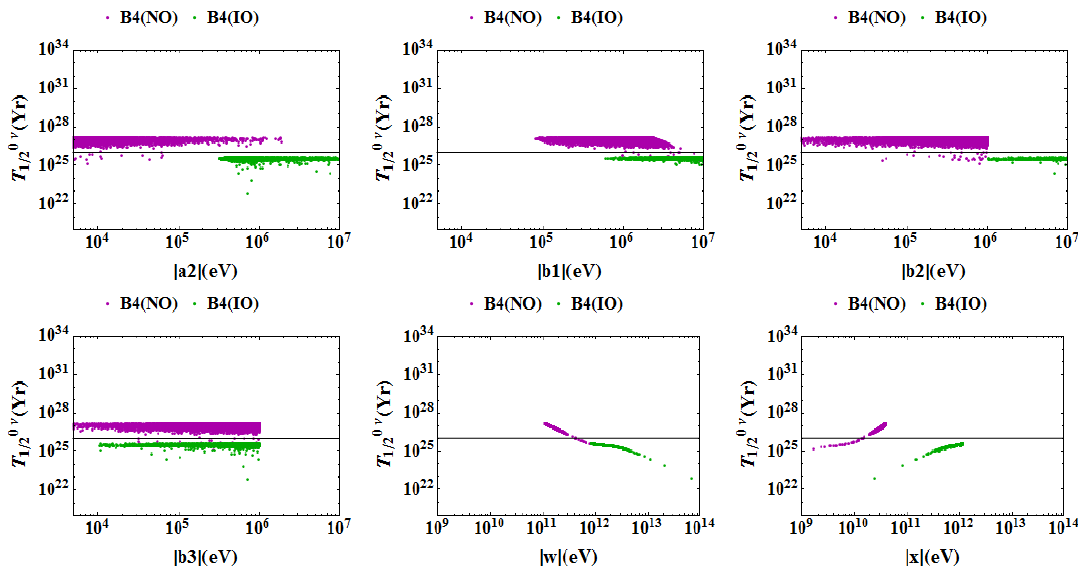
Figure 23 . Total contribution to half-life governing NDBD as a function of the model parameters for the class B4. The horizontal line represents the KamLAND-Zen lower limit.